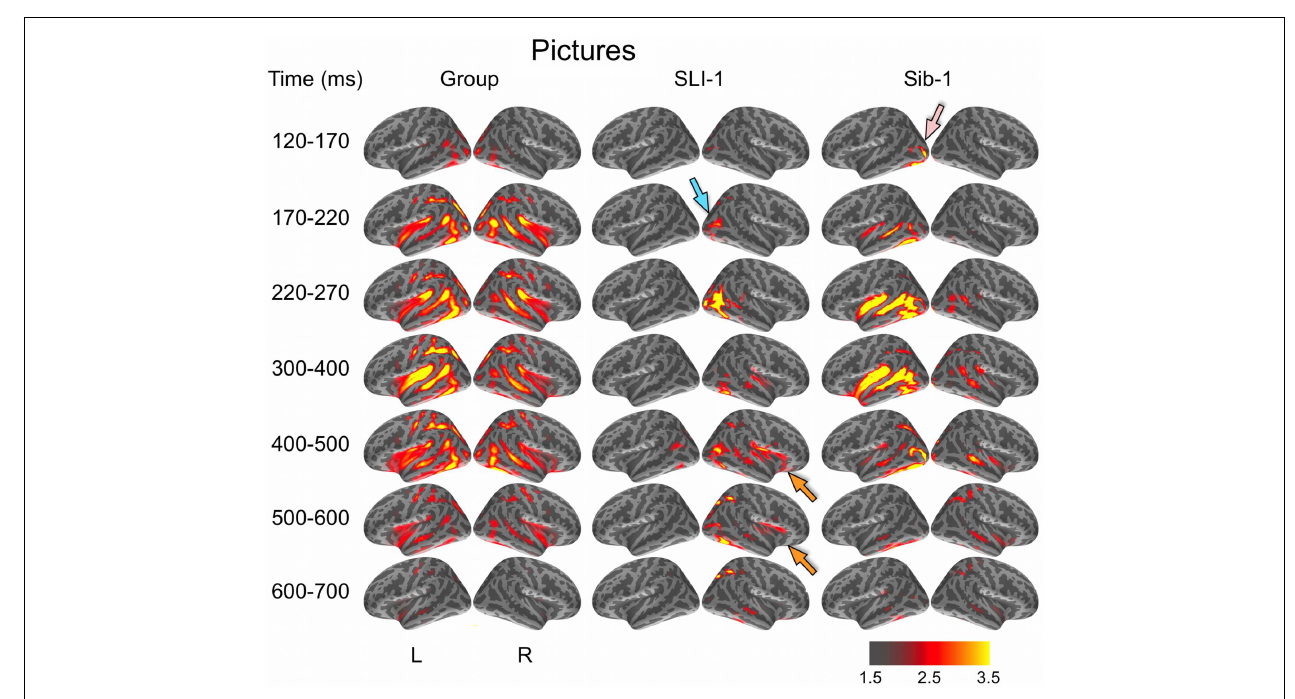
somewhat delayed in time (blue arrow) in relation to his sister (pink arrow). During latencies typically associated with semantic encoding, he showed activity within right temporal, perisylvian, and frontal opercular regions (orange arrows), although weaker than for words. Color scale represents square root of F values, which are a measure of